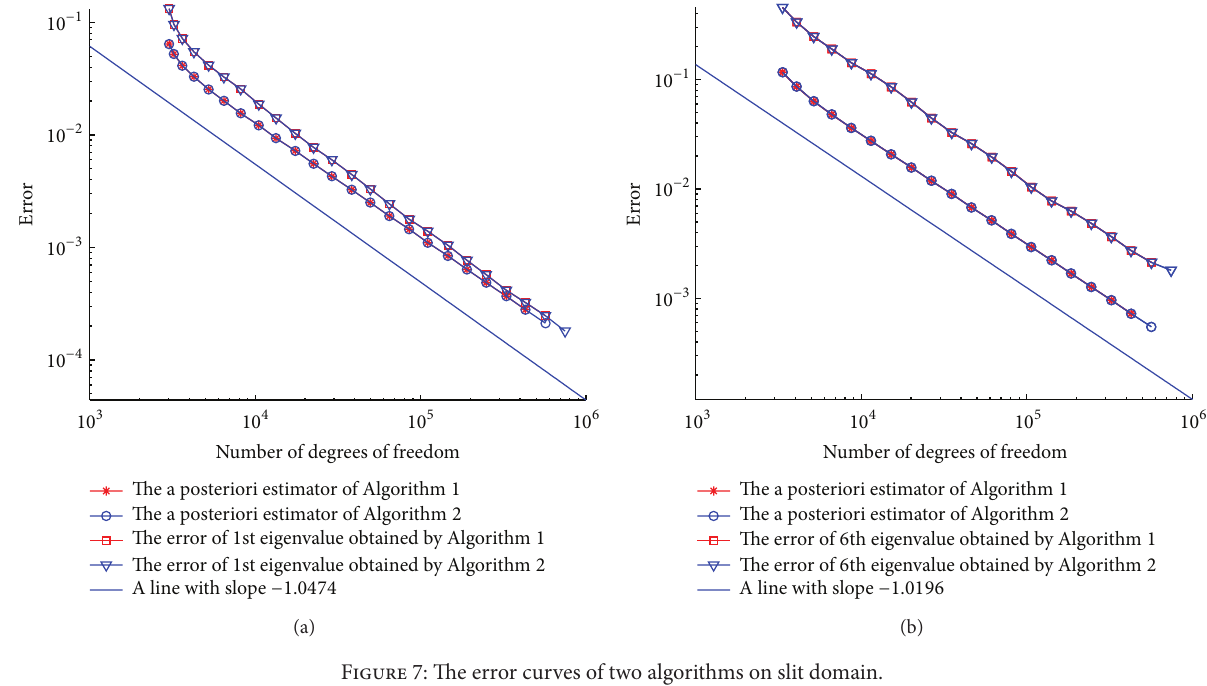
Figure 7: The error curves of two algorithms on slit